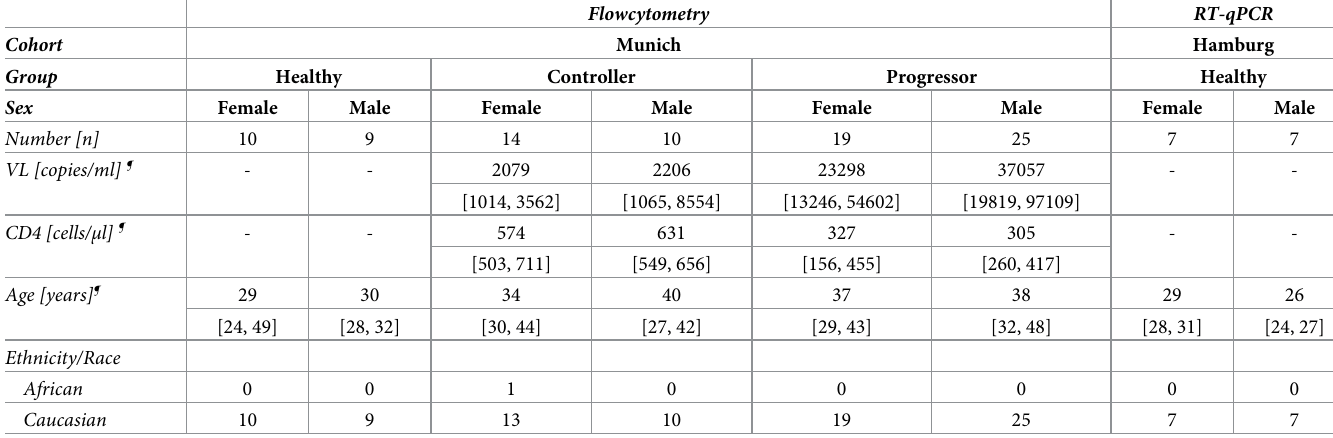
Table 1. Samples for RT-qPCR and